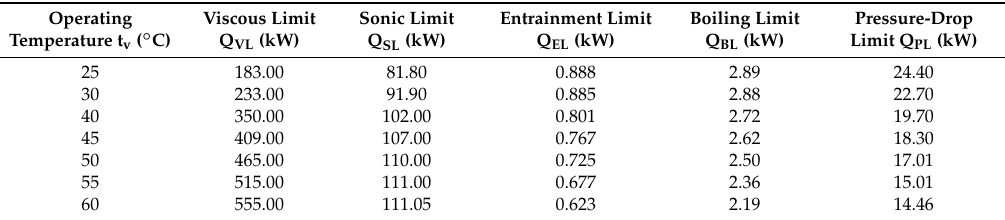
Table 2. Impact of the operating